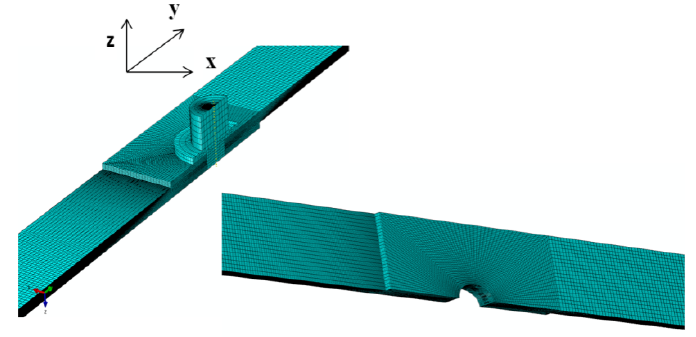
Figure 2. Finite element model of the bolted joints, same mesh density was used for the double bolt joints.